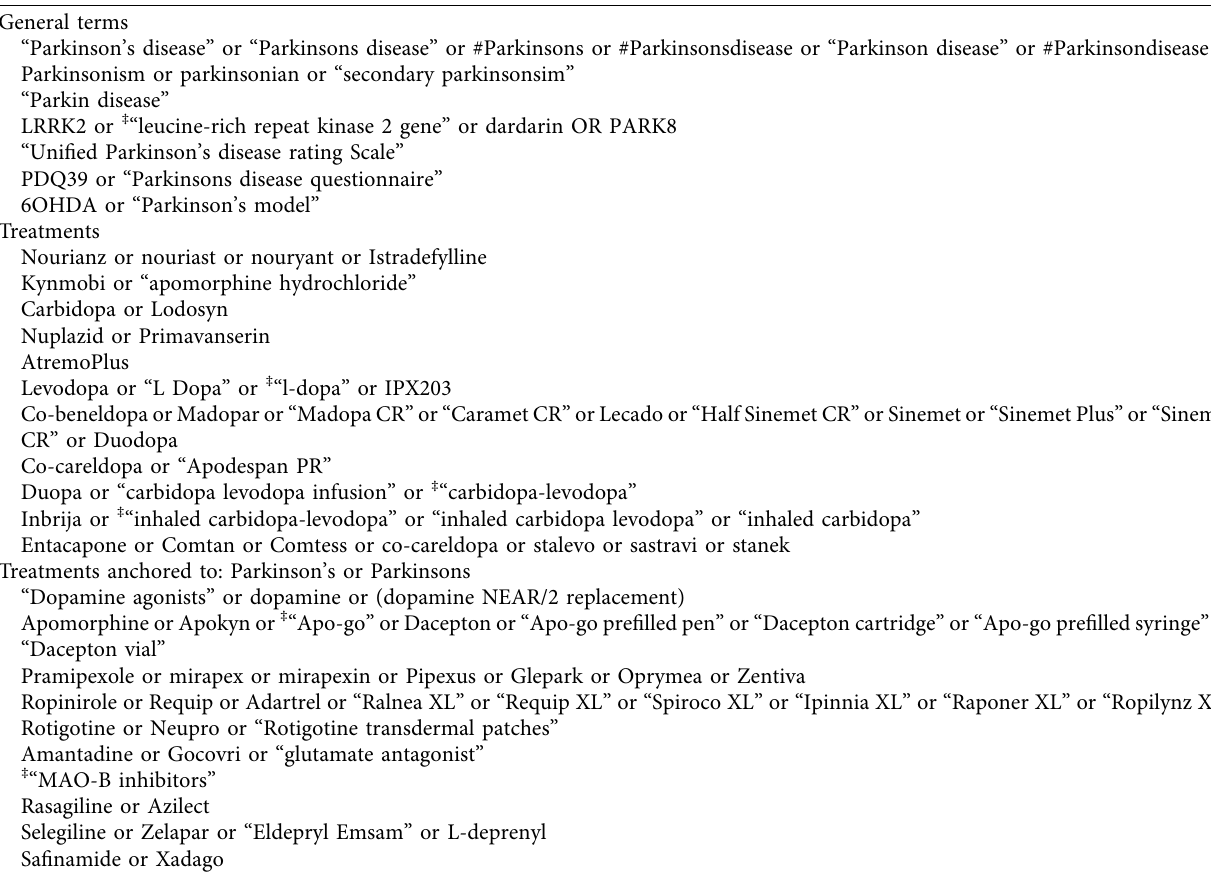
Table 1: Overview of key search